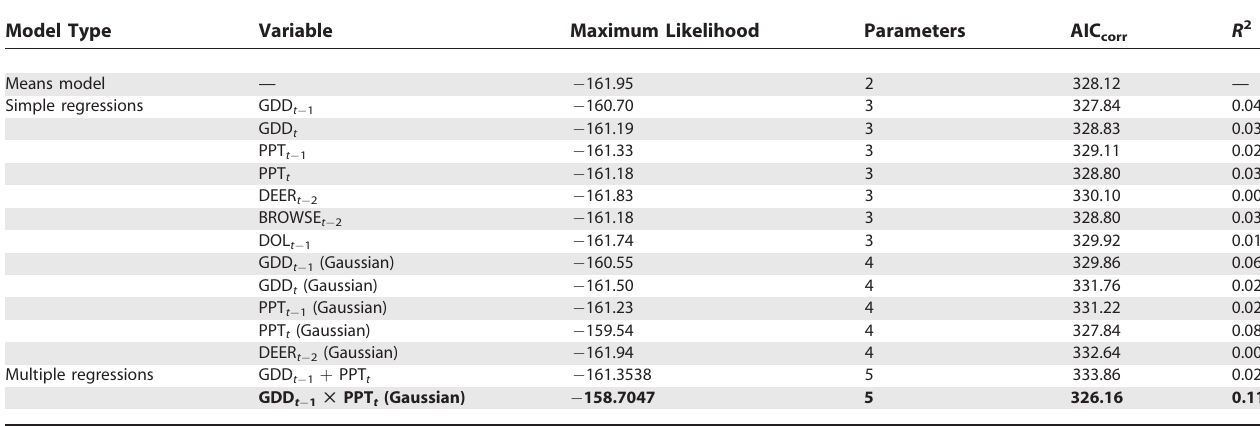
Table 5. Model Comparison Statistics for Independent Variables Potentially Influencing the DIN Based on the Full Dataset (58 Plot